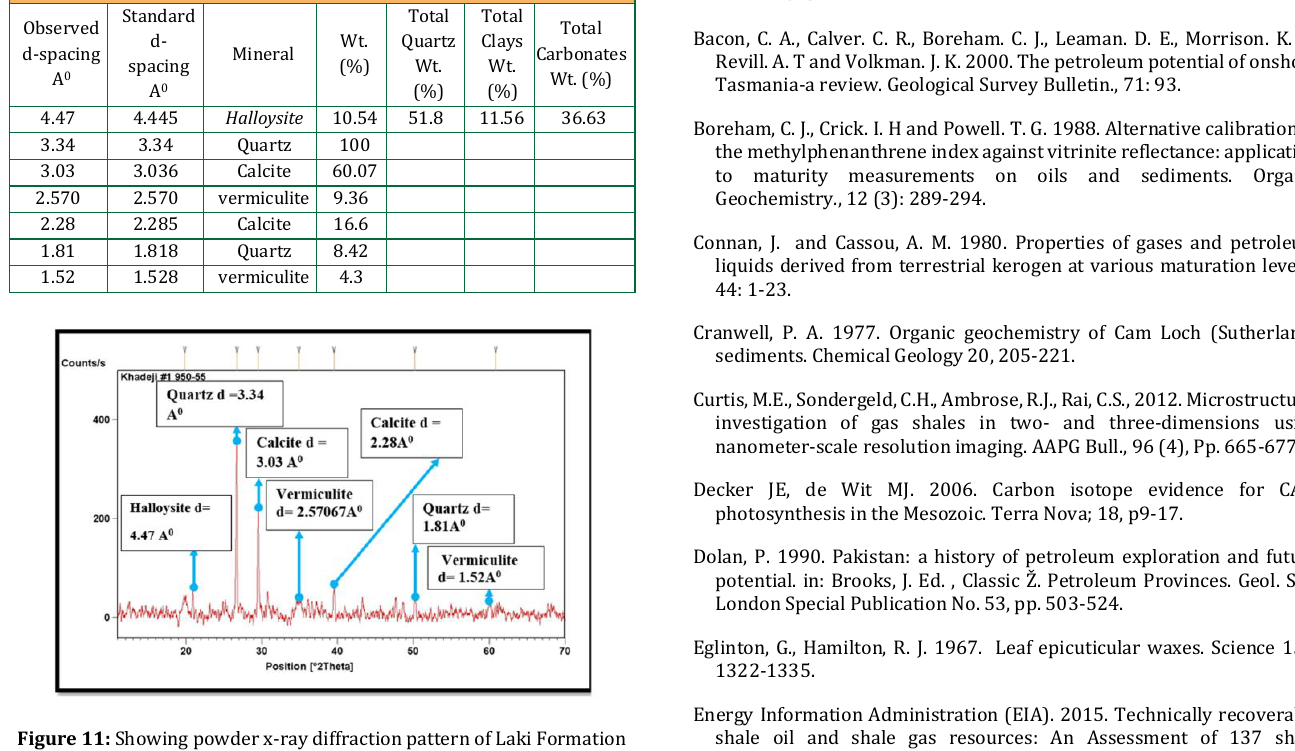
Table 2: Showing mineralogical composition of Laki shale in Khadeji # 01.